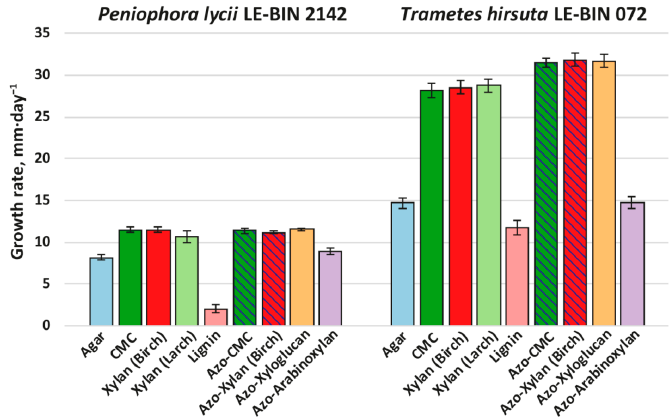
Figure 3. Growth rates of P. lycii LE-BIN 2142 and T. hirsuta LE-BIN 072 during their cultivation on solid agar media containing various wood components and their azo-labeled derivatives—CMC, birch xylan, larch xylan, lignin, azo-CMC, azo-birch xylan, azo-xyloglucan and azo-arabinoxylan.